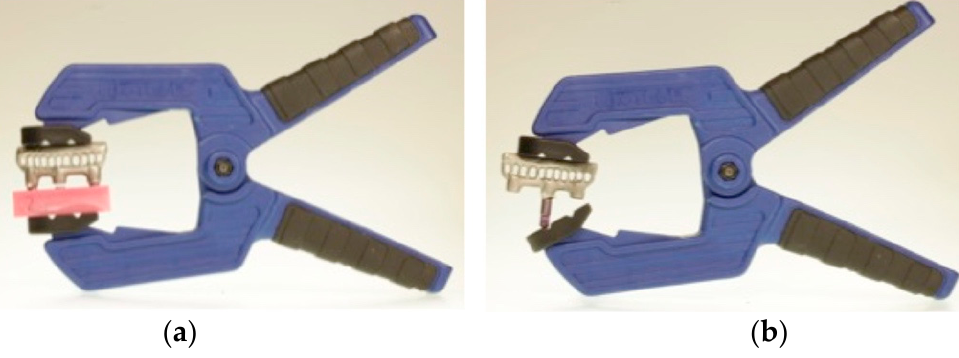
Figure 3. Fixed castings with the molding press with a force of 50 N. ( a ) FDP; ( b ) SC. After setting, cement residues were removed with a plastic curette. Half of the specimens were stored in isotonic saline solution (Isotonic Saline Solution 0.9%, Braun, Melsungen, Germany) for 24 h at a temperature of 37 ◦ C (NaCl group), whereas the other half (Thermo group) was exposed to thermocycling with 10,000 cycles at +5 ◦ and +55 ◦ C (“hard thermocycling”) with a dwell time of 30 s [30]. The 10,000 thermocycles correlate with the aging of the cement for one year in a patients’ mouth and represent